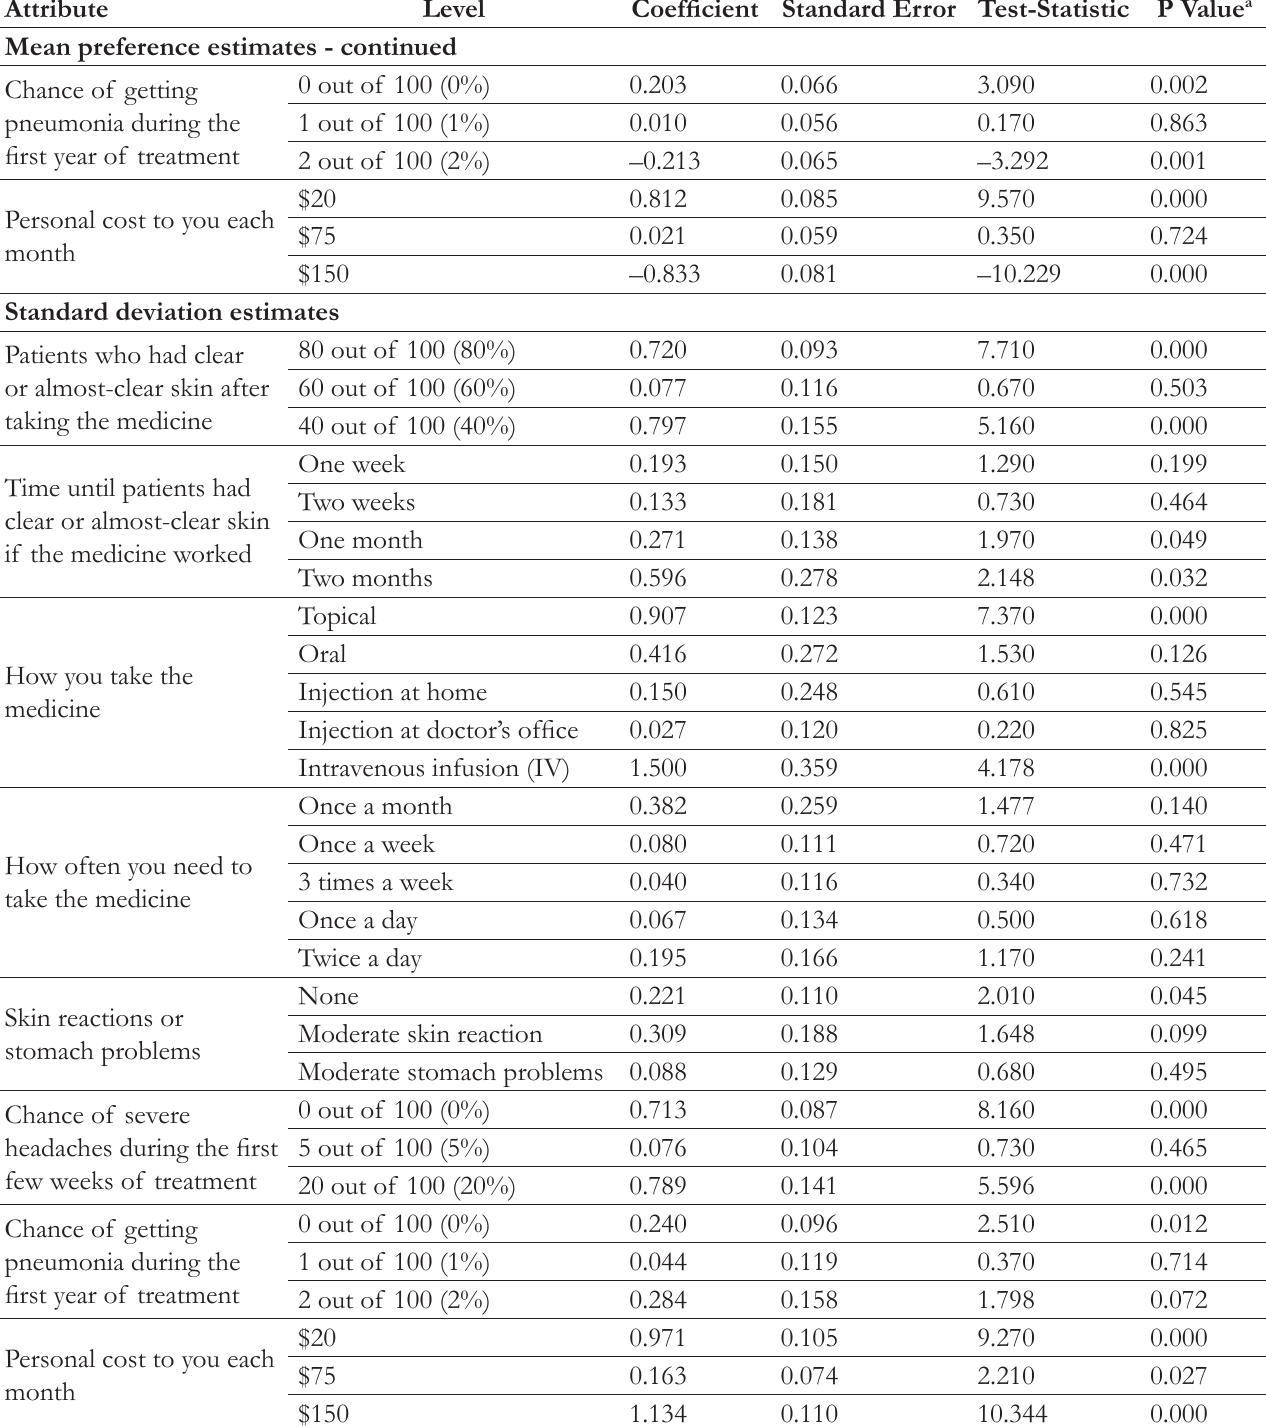
Table 4. Mean Preference Estimates and Standard Deviation of Preference Estimates Based on Treatment Choices for the Pooled Sample (N = 397) - continued Attribute Level Coefficient Standard Error Test-Statistic P Value